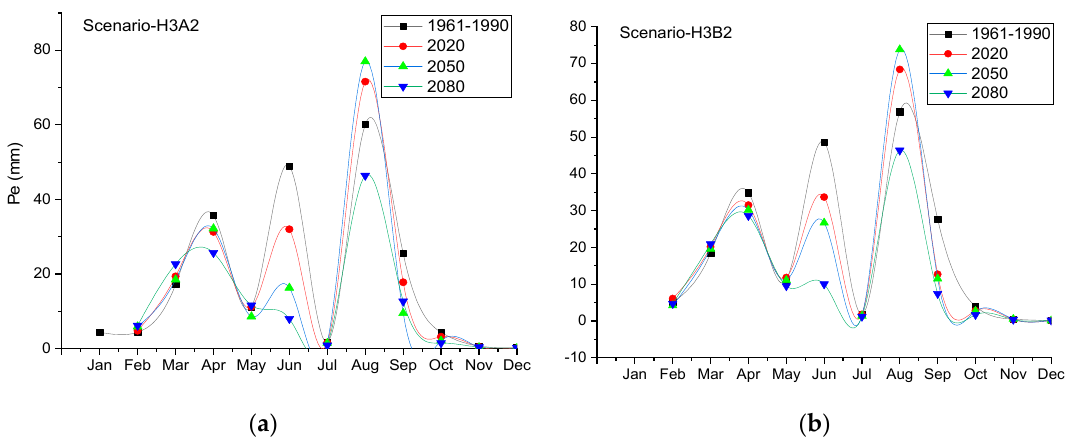
Figure 7. Mean monthly changes in effective precipitation (mm) in the baseline (1961–1990) and the future (2020s, 2050s, and 2080s) under ( a ) H3A2 and ( b ) H3B2 scenarios.